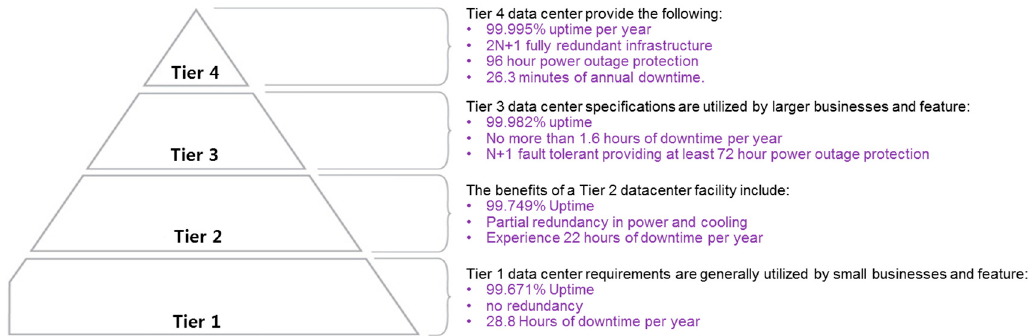
Figure 1. Data center tier standards for evaluating the quality and reliability of the server hosting ability of a data center [3].